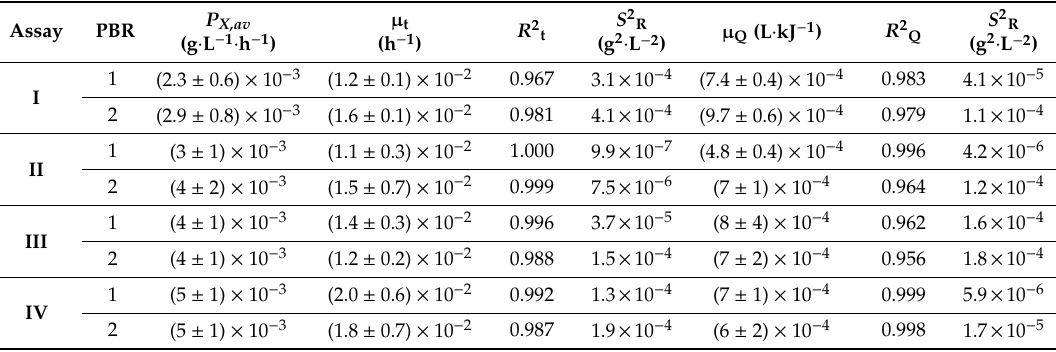
Table 2. Productivities and specific growth rates for each